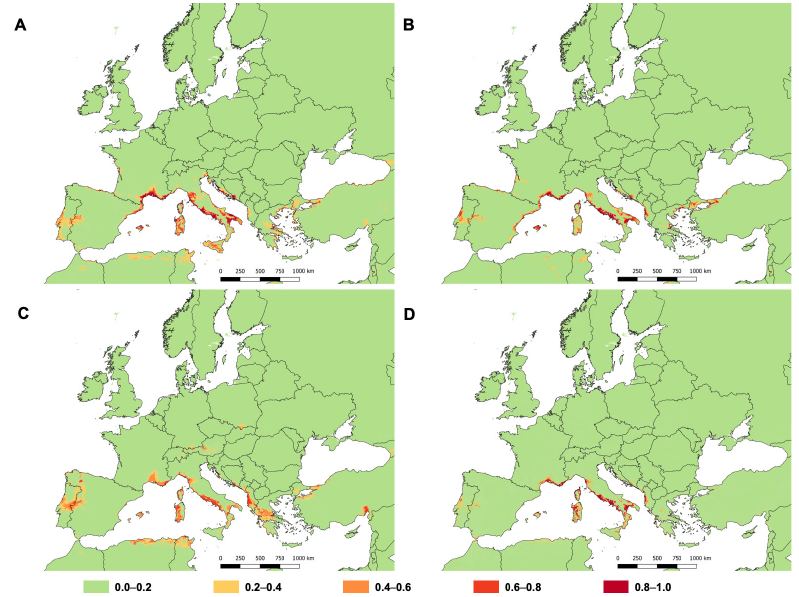
Figure 4. Distribution of suitable areas for Toumeyella parvicornis in Mediterranean Europe based on bioclimatic variables using Generalized Linear Model (GLM) ( A ), Multivariate Adaptive Regression Splines (MARS) model ( B ), MaxEnt model ( C ), and Random Forest (RF) model ( D ). Different colours indicate “classes of suitability” (green = very low; yellow = low; light orange = intermediate; dark orange = high; red = very high).